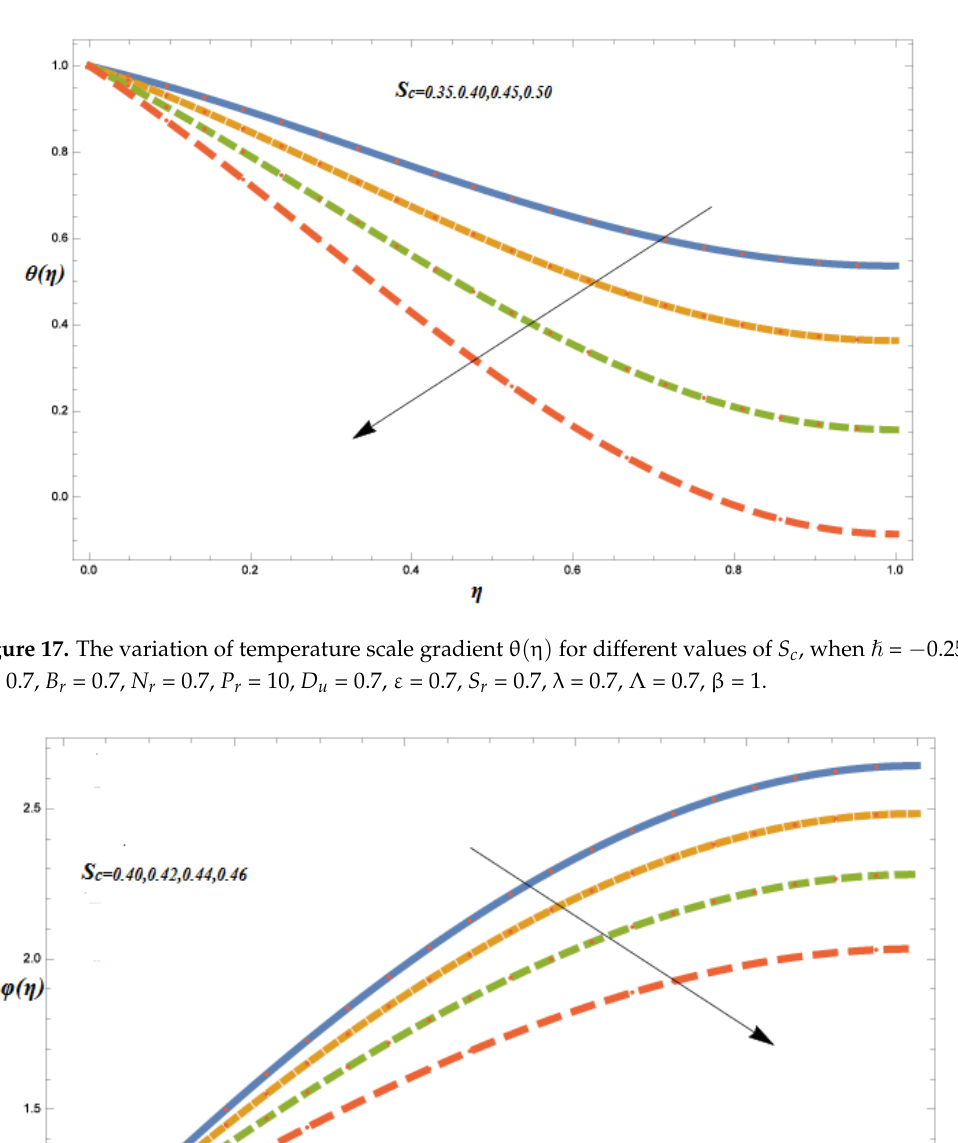
Figure 16. Variations in concentration field ( )   occur for different values of S r , when  = − 0.25,